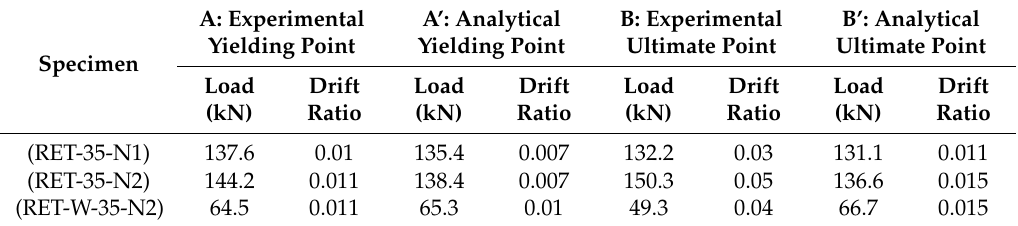
Table 10. Yielding and ultimate load-drift ratio data for the experimental and analytical results (Youssef et al. [24]).